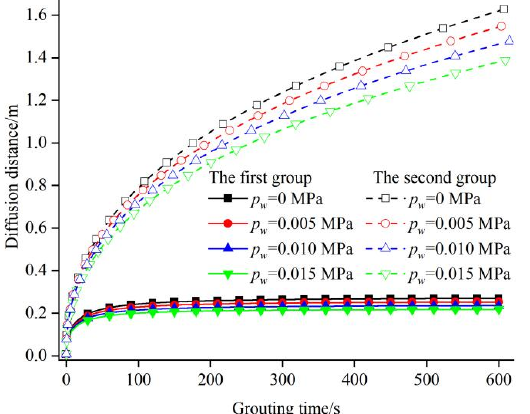
Figure 6. Schematic diagram of the diffusion radius with different groundwater pressures.